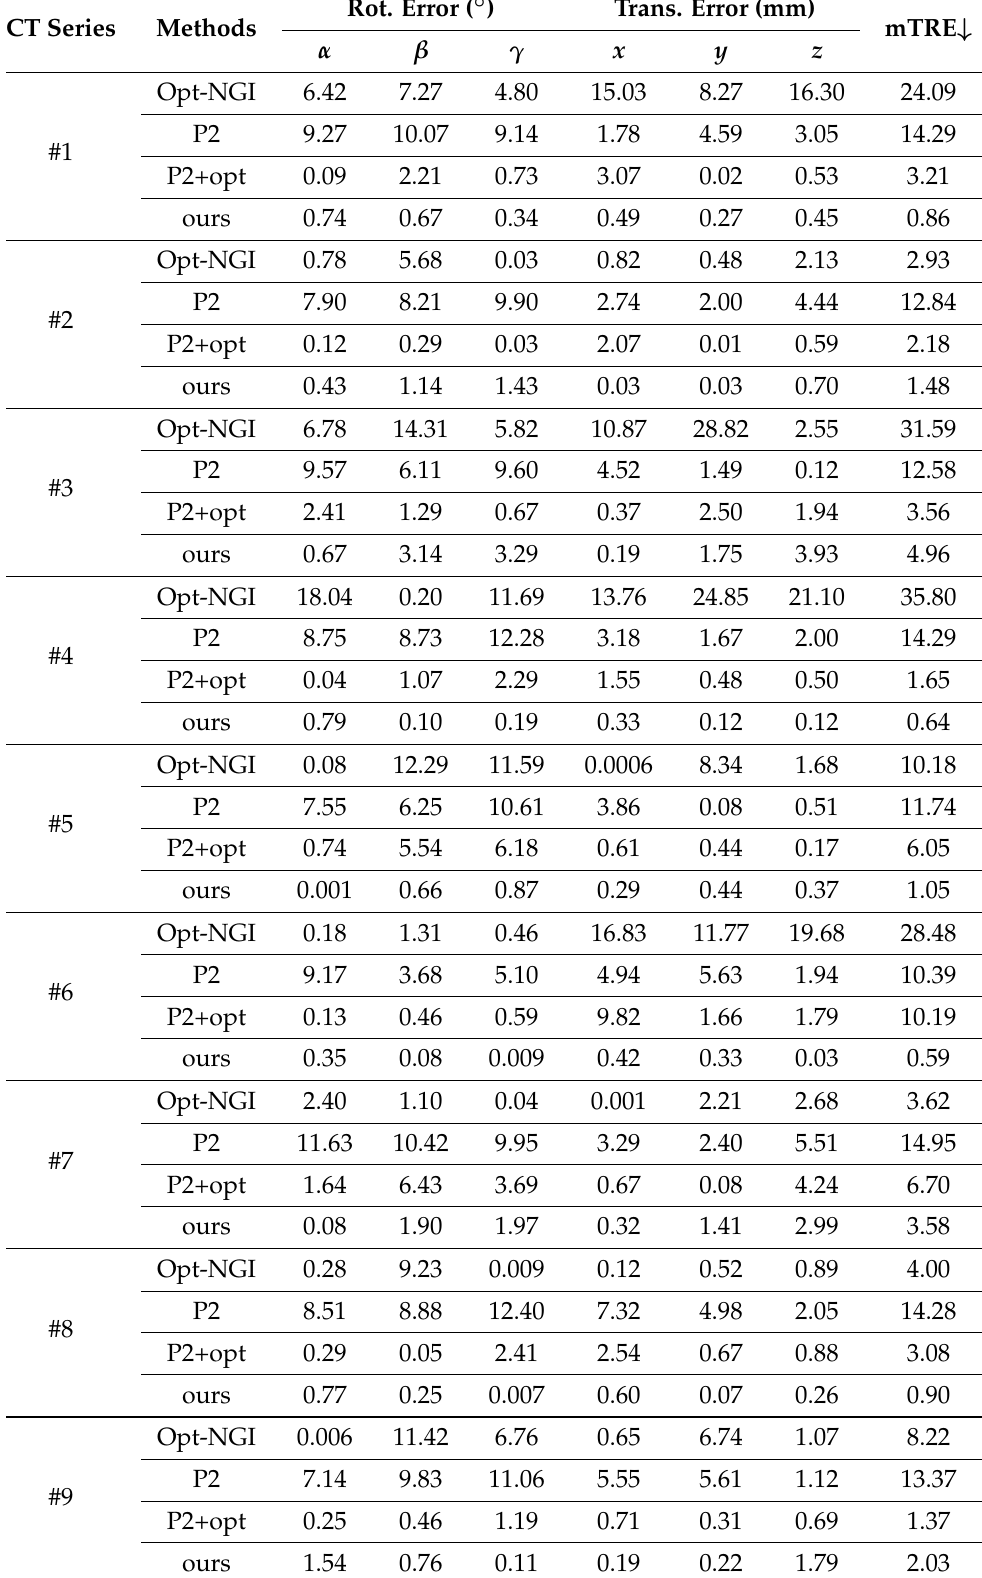
Table 1. Specific errors in 6 DoF and mTRE of three methods on the CT-DRR